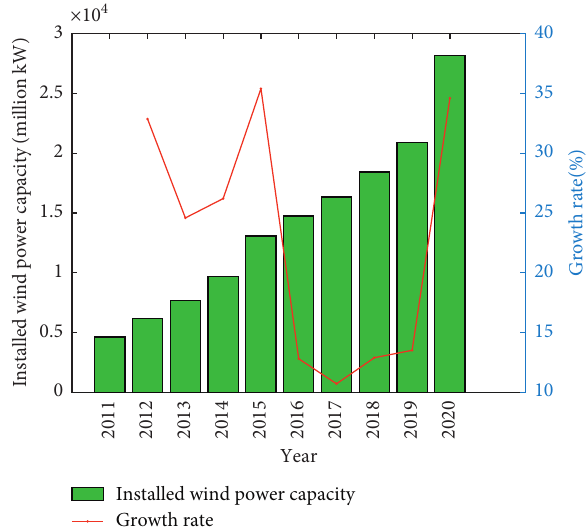
Figure 1: Installed capacity and growth rate of wind power